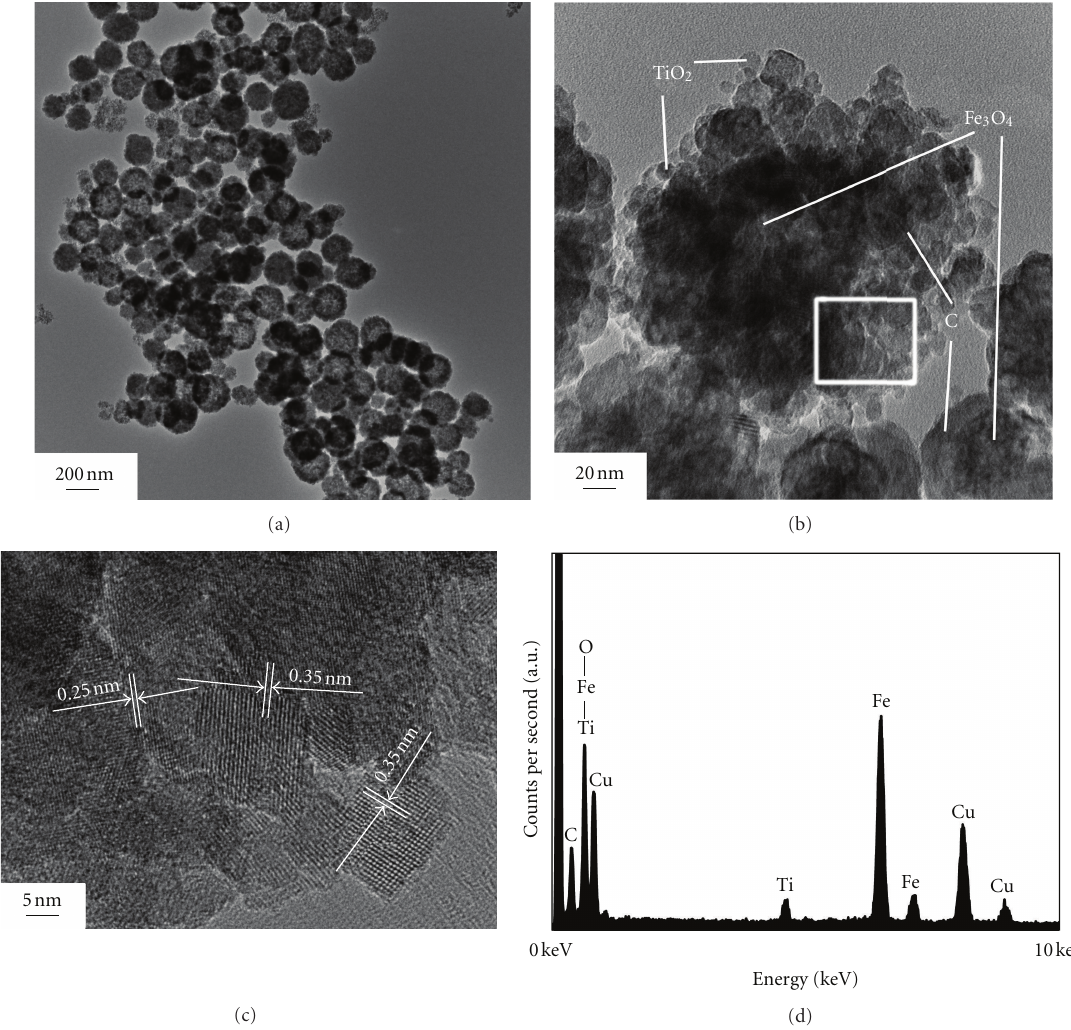
Figure 3: TEM images of (a) Fe 3 O 4 , (b) Sample B, HRTEM image (c), and EDS result (d) of the selected area in image